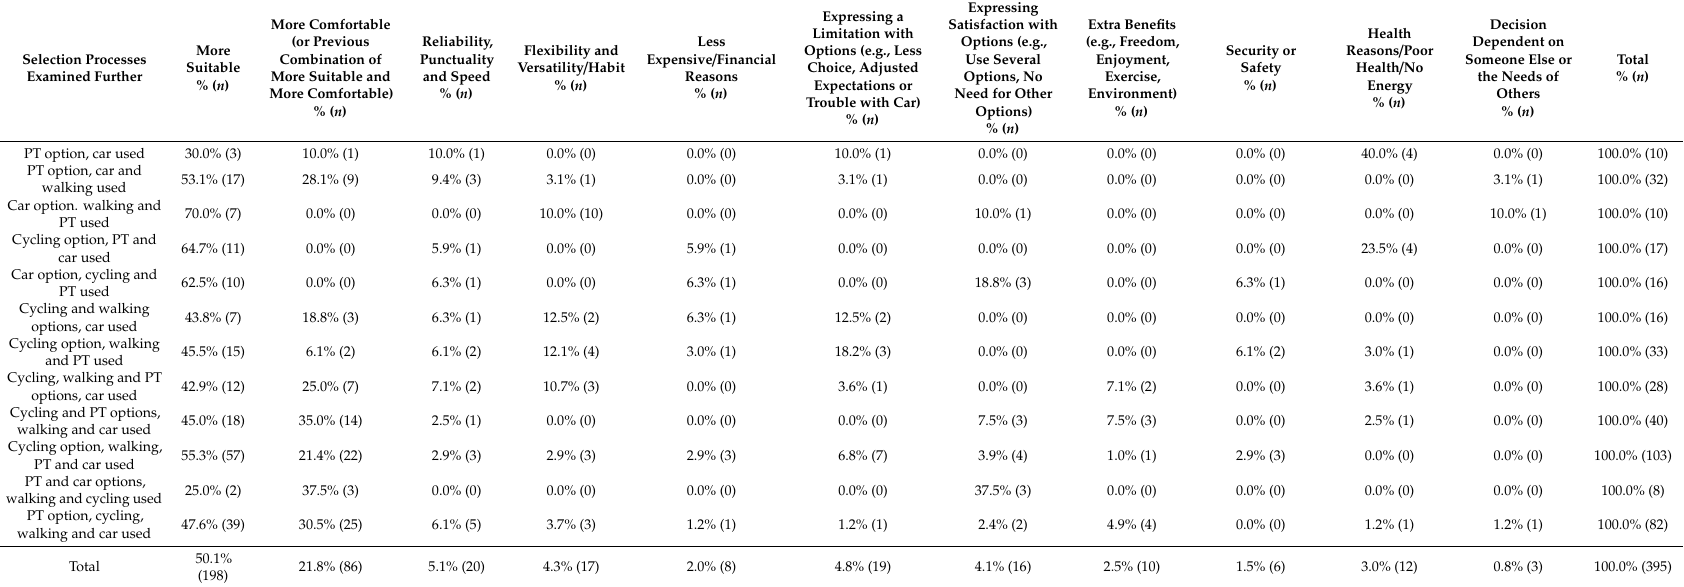
Table 5. Cross-tabulation of selection process groups of interest with themes of reasons for modal selection based on the first recorded reason ( n = 395) *.